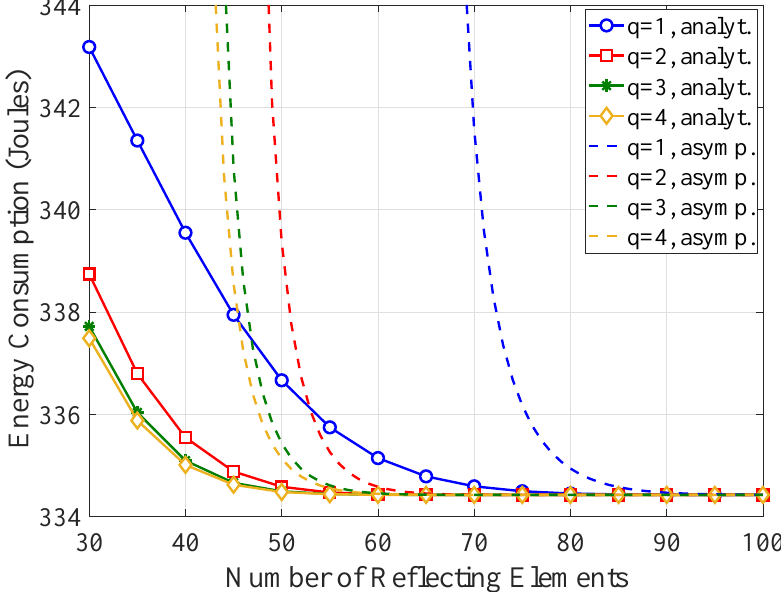
Figure 6. The WTEC as a function of the number of reflecting elements for a varying number of quantization